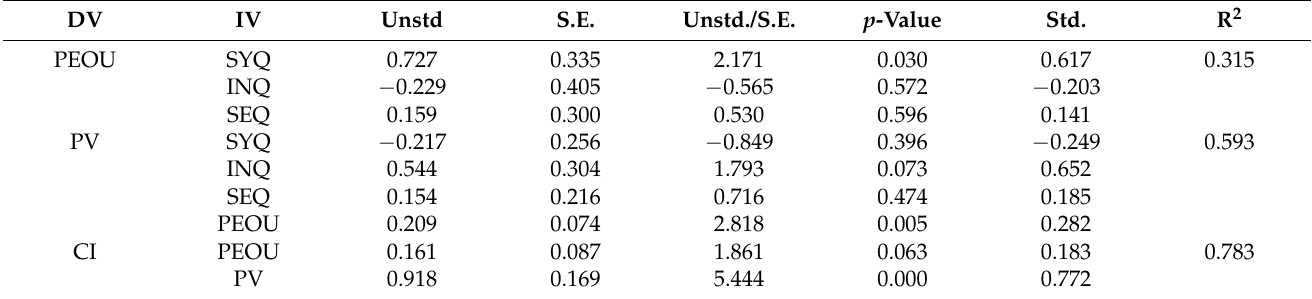
Table 6. Regression coefficient of research model II (TAM-IS Success Integrated